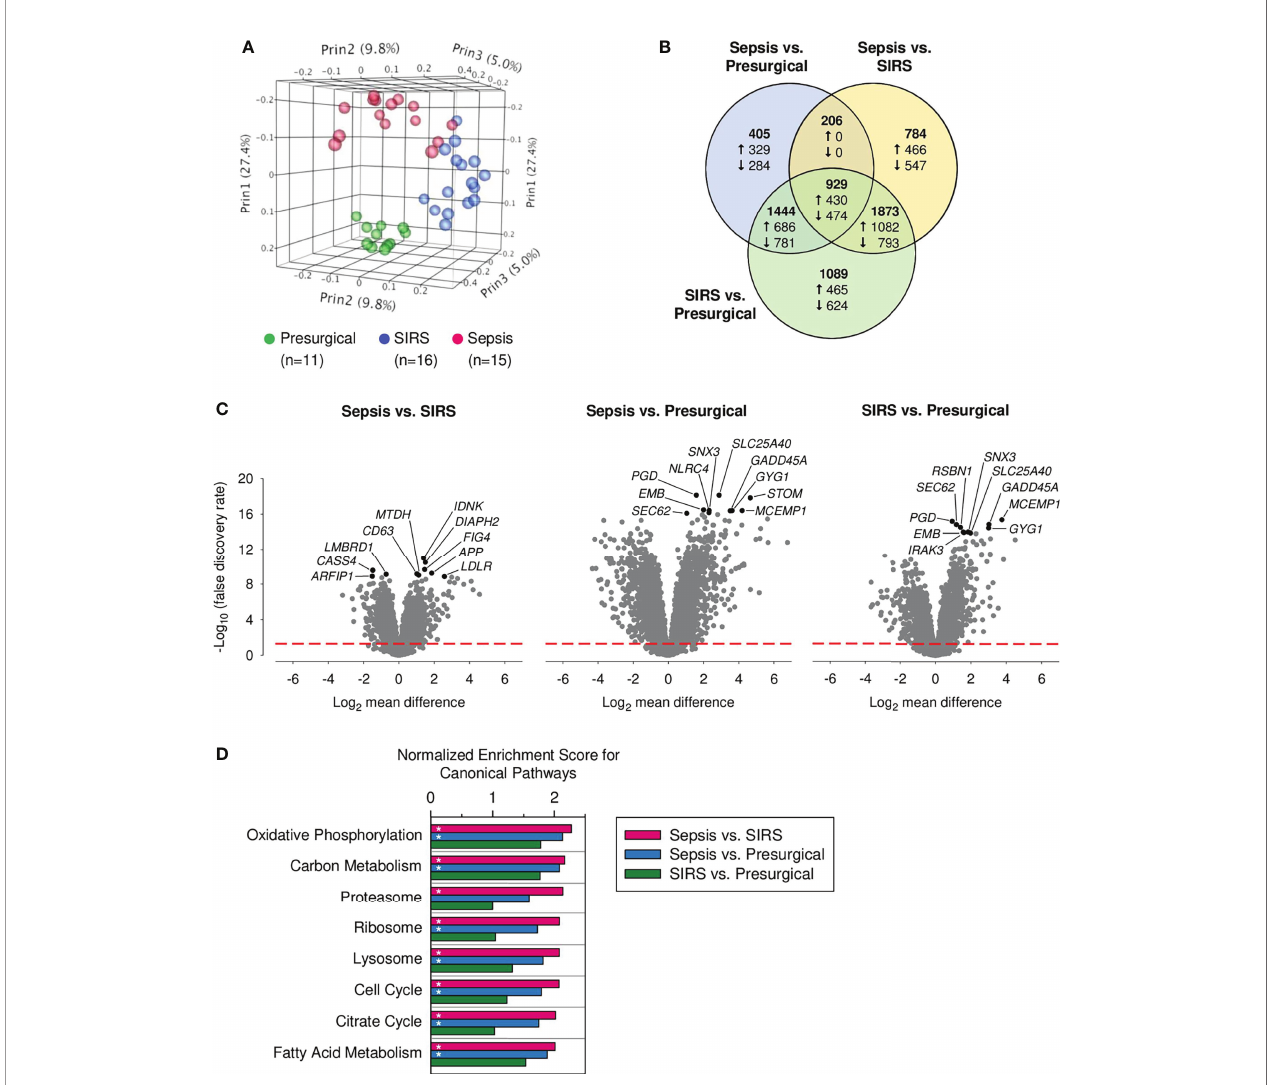
FIGURE 1 | Global transcriptomic responses of discovery set CD15 + cells. Data from our previously published whole-genome microarray dataset (24,733 probes) for indicated numbers of presurgical, SIRS, and sepsis patients from the discovery cohort were analyzed. (A) Principal component analysis. Percentages represent the variance captured by the fi rst three principal components (Prin1, Prin2, and Prin3). (B) Venn diagram for differentially expressed genes (DEGs) in the three pairwise patient group comparisons (total number of DEGs = 6,730; statistical signi fi cance threshold: false discovery rate adjusted a < 0.05). The numbers printed in bold represent the distribution of all DEGs, including up- and downregulated genes together. The numbers for the distribution of up- and downregulated genes, as per the indicated comparisons, are preceded by an upward and downward arrow, respectively. Note that, due to differences in the distributions, numbers of up- and downregulated genes add up to the numbers of all DEGs only for a given comparison, i.e., within each of the three circles. (C) Volcano plots for all three pairwise patient group comparisons of gene expression. The ten statistically most signi fi cant results for DEGs are identi fi ed by gene symbols. They are printed in black with the remainder in gray. The red dashed red line indicates the threshold for statistical signi fi cance. (D) Enrichment of canonical pathways in the discovery set CD15 + cells. Normalized enrichment scores for the eight CD15 + cell attributable KEGG pathways with the lowest false discovery rate (FDR)-q values from the sepsis vs. SIRS comparison. Bars marked with an asterisk indicate an FDR-q value